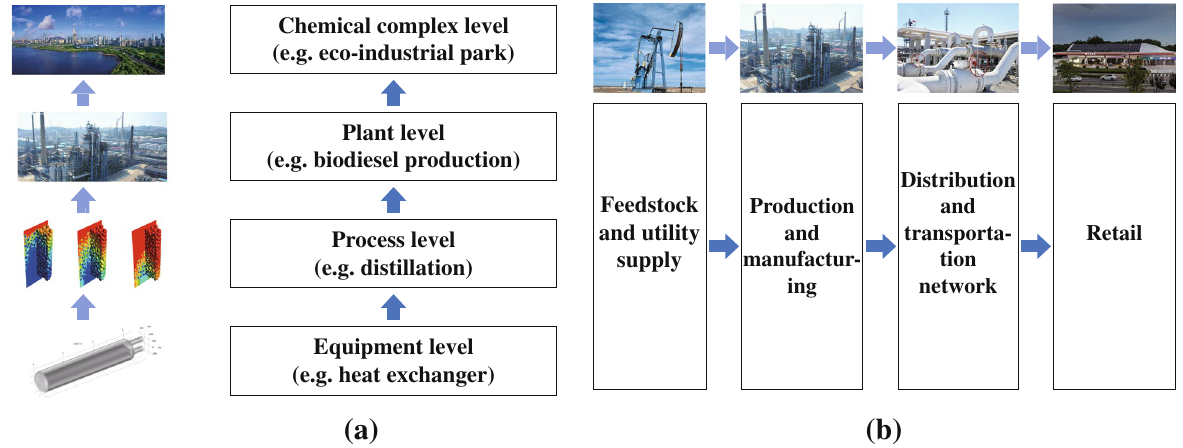
Fig. 3 Landscape of energy system: a hierarchy perspective; b horizontal